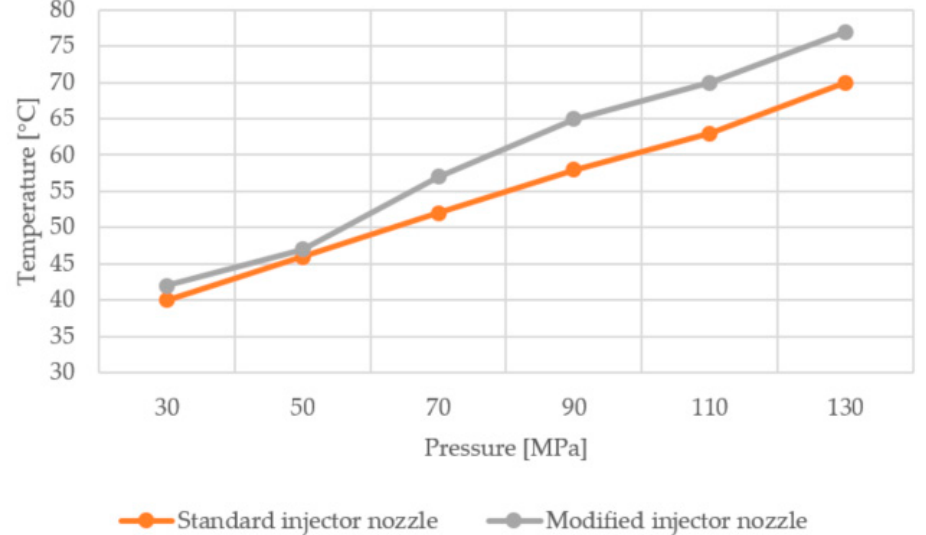
Figure 12. Fuel temperature results at the discharge from the atomizer with different pressures in the system.